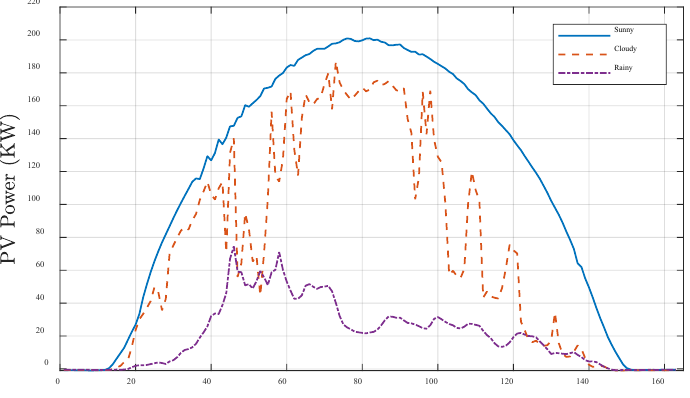
Figure 4. PV power generation in different weather types.